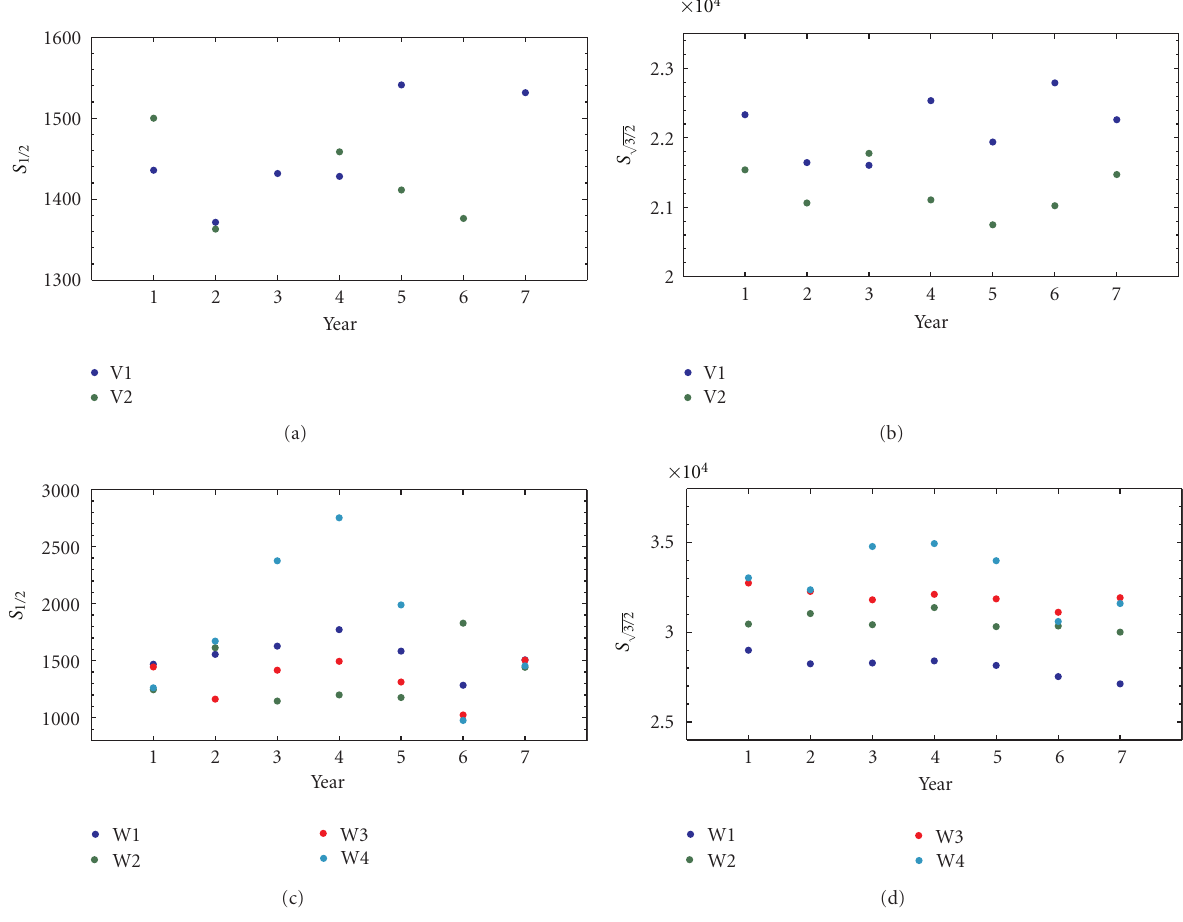
Figure 19: The S statistics of WMAP data at each D/A and